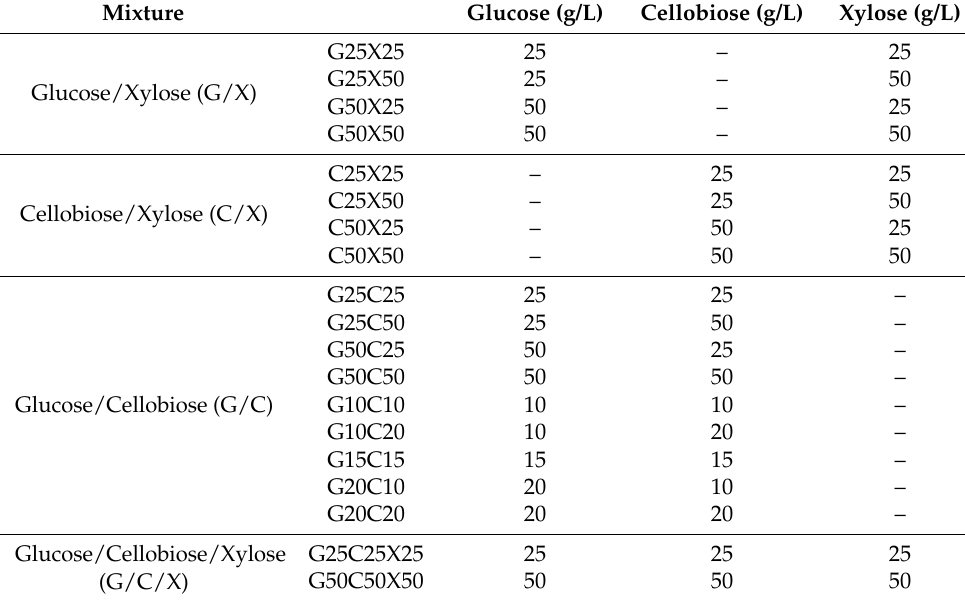
Table 1. Design of mixed sugars used for lactic acid production in batch fermentations in the present